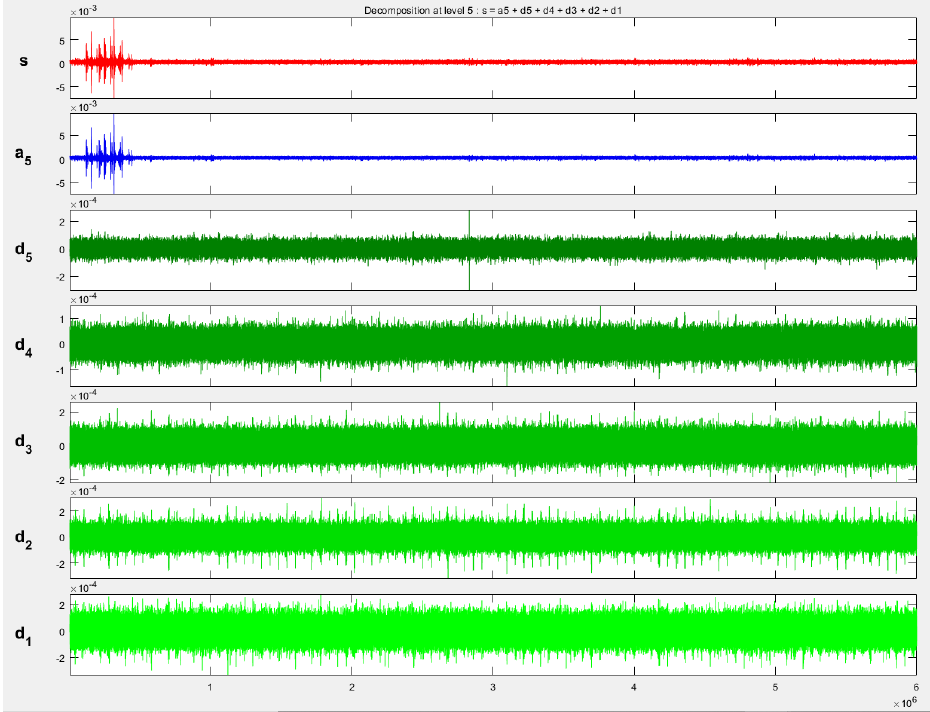
Figure 28. Waveform decomposition diagram of noise S1.